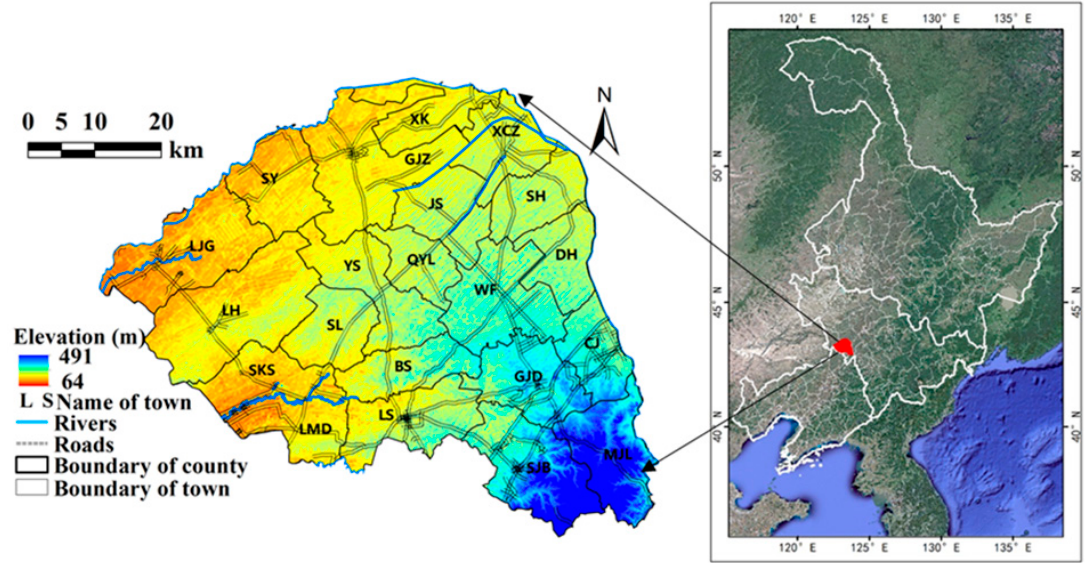
Figure 1. Schematic diagram of the geographical position of Lishu County. Notes: LJG: Liujiaguan